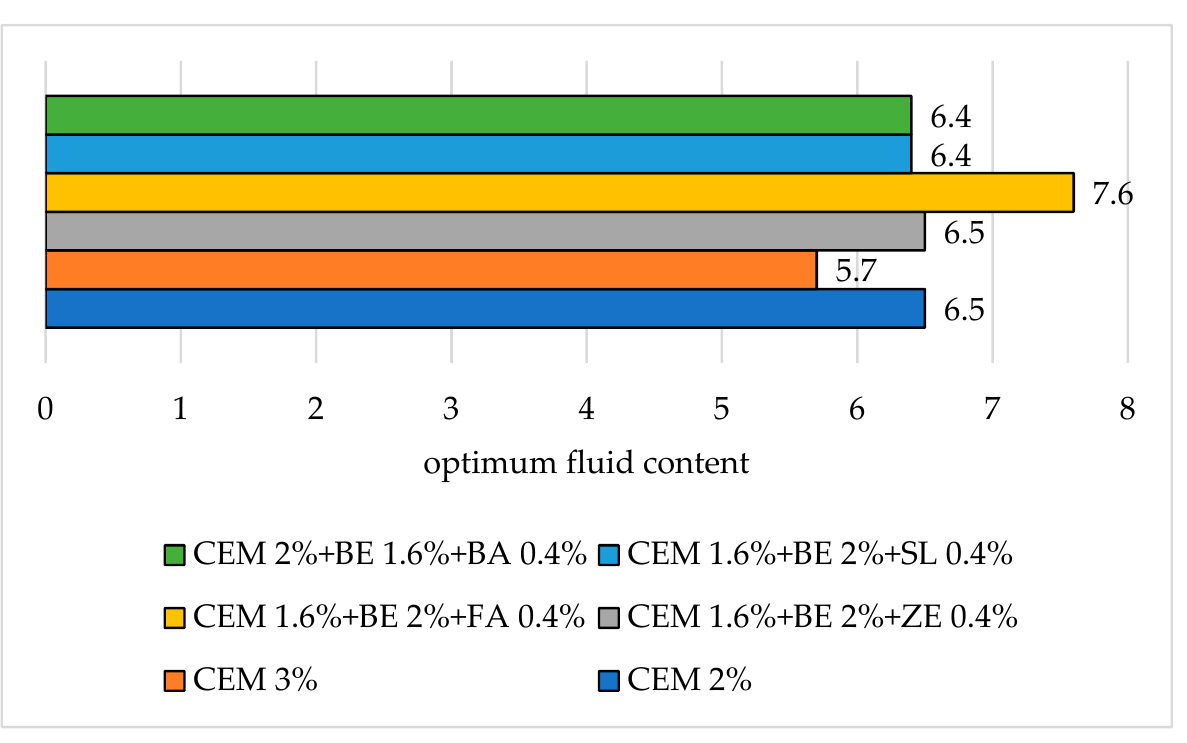
Figure 1. Optimum fluid content for different mixtures.